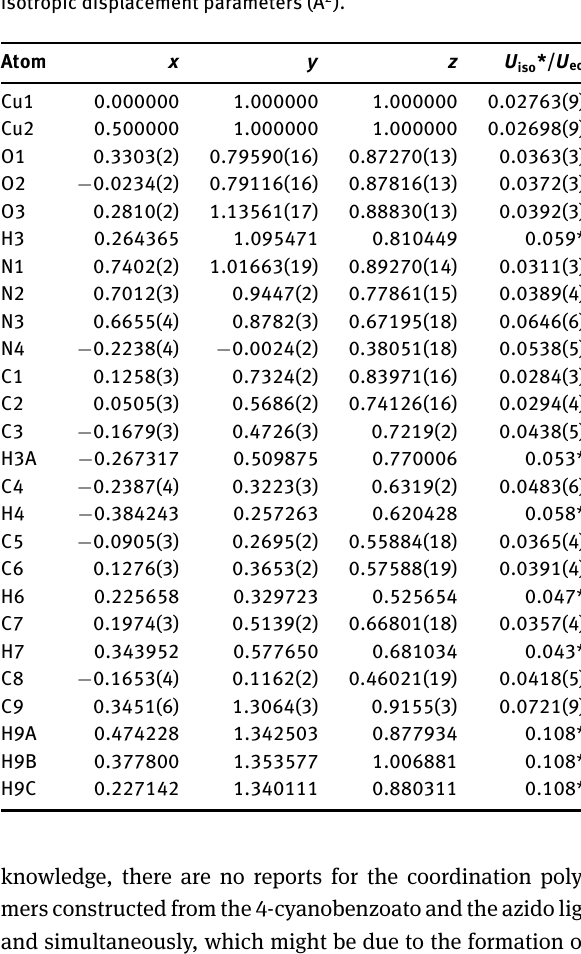
Table 2: Fractional atomic coordinates and isotropic or equivalent isotropic displacement parameters (Å 2